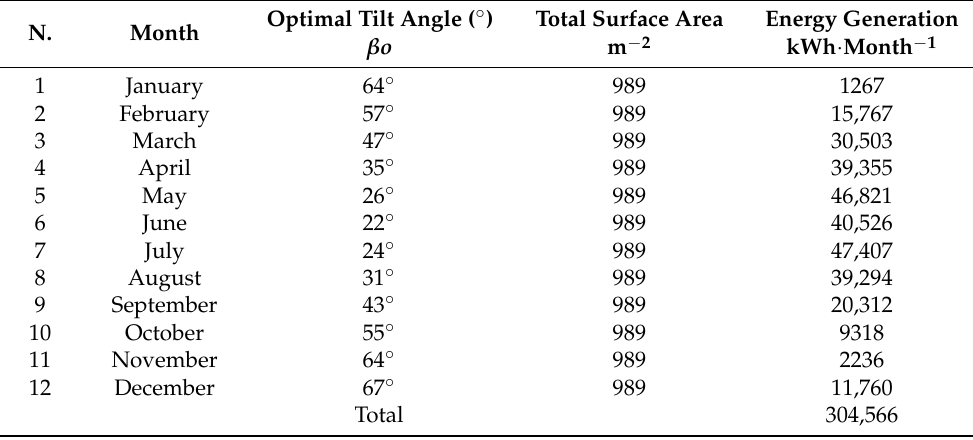
Table 5. Energy generation according to the optimal tilt angle ( β o ) from January to December 2022.